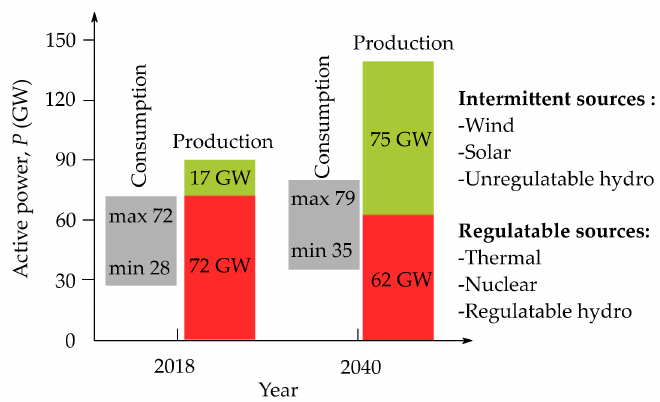
Figure 7. Production and consumption in the NPS (2018) and forecast by 2040